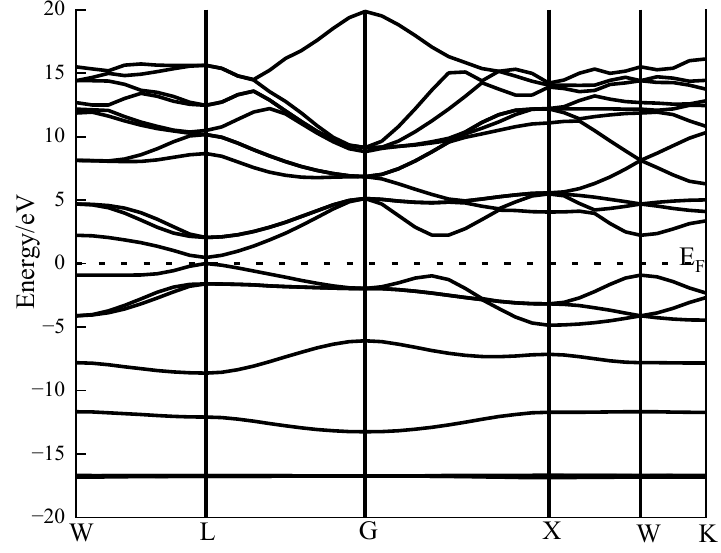
Figure 4. Band structure of perfect galena.